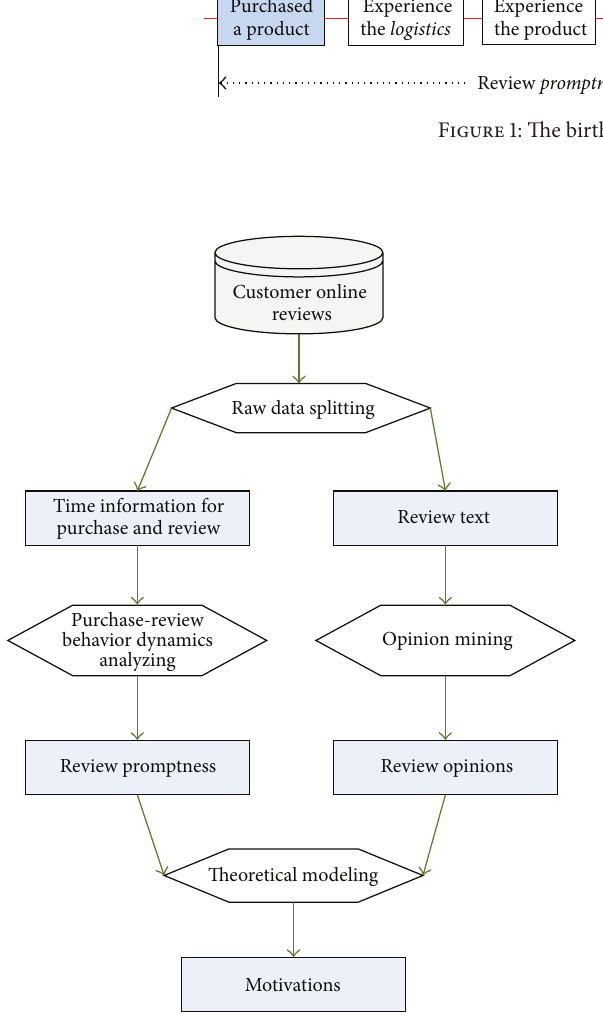
Figure 2: The research